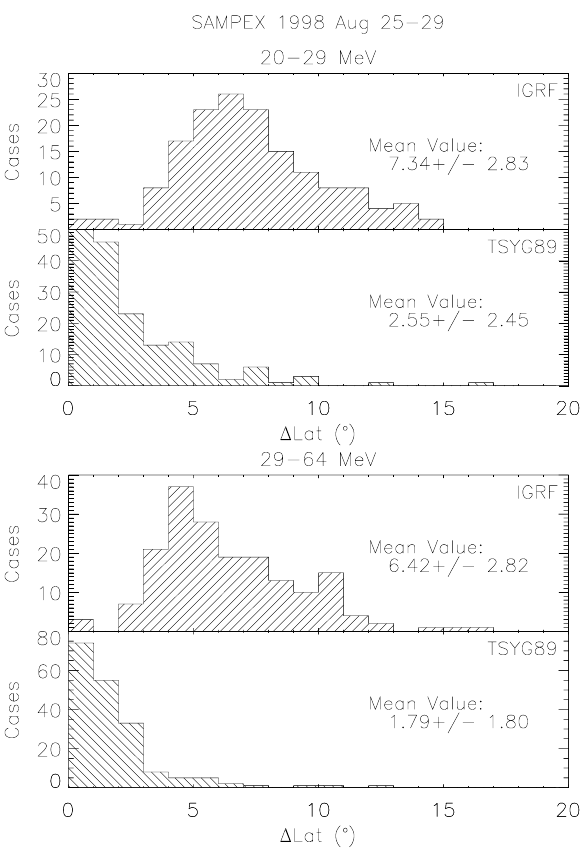
Fig. 2. Top panels: Histograms of numbers of cases of 1 Lat for the 20–29MeV protons with the IGRF model (top) and Tsyganenko model (bottom). The observing period is 25 to 29 August 1998. Each case is a difference between the calculated (IGRF or Tsy- ganenko) and observed PET geographic cutoff latitudes. Bottom panel: Same as the above but for the 29–64MeV protons.